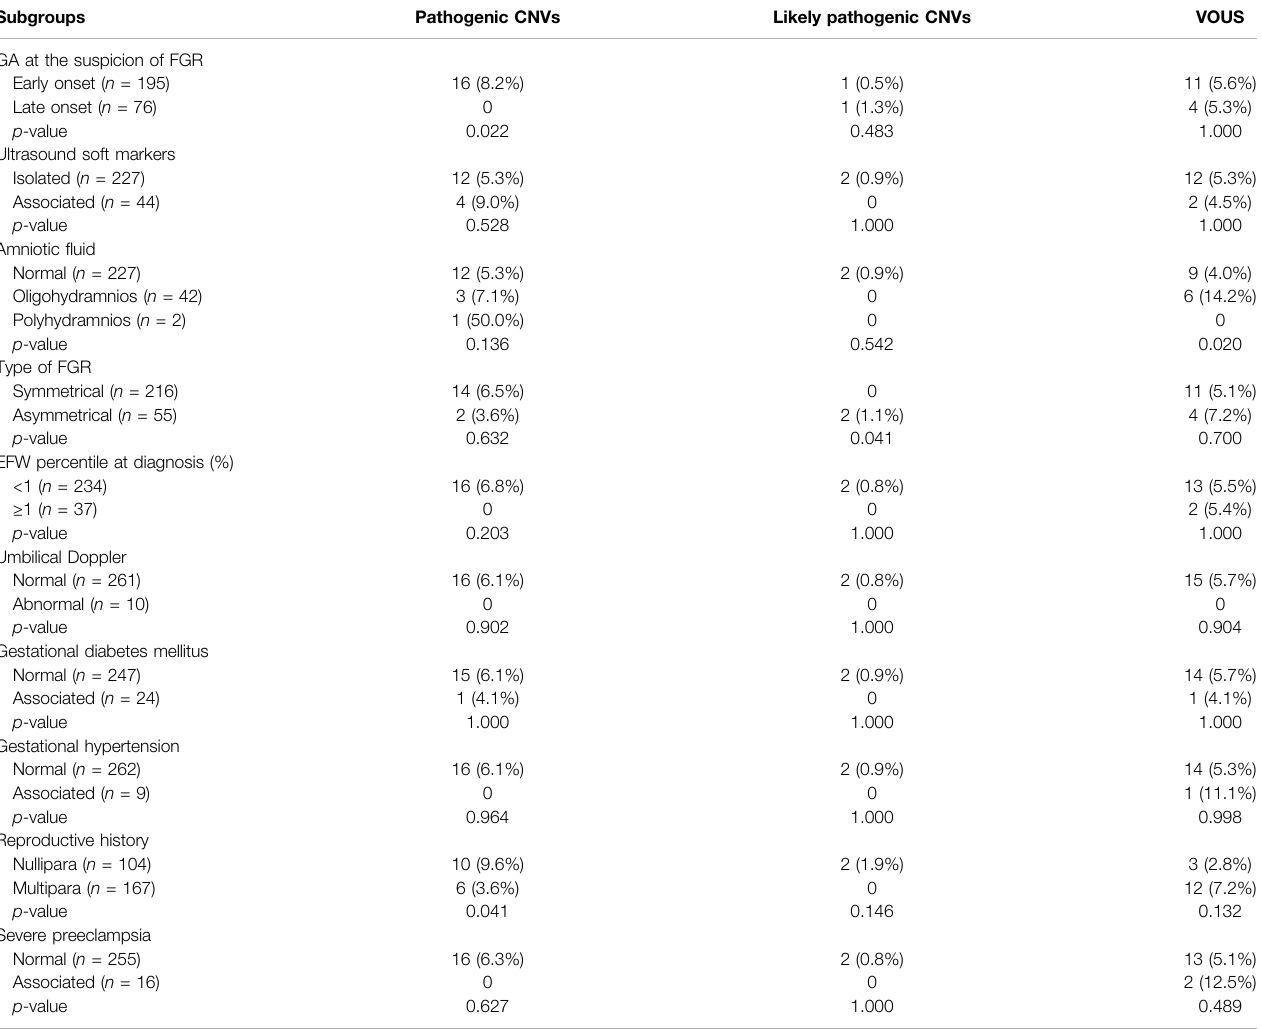
TABLE 1 | Strati fi ed analysis of CNV detection in isolated FGR.